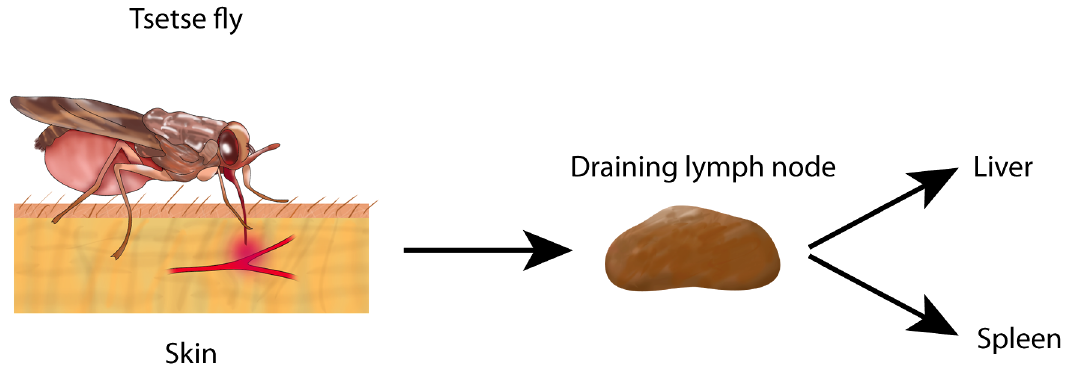
Figure 1. Mode of natural infections by African trypanosomes. Infected tsetse flies bite the host by inserting the proboscis into the skin, inject saliva into the site, and puncture a small blood vessel, resulting in a small hemorrhage. The tsetse fly depicted here is sucking blood from the hemorrhage. During this process, trypanosomes are deposited into the skin. Trypanosomes enter the lymph system and then reach the draining lymph node and the bloodstream. Trypanosomes will circulate in the bloodstream. Whole trypanosomes or fractions thereof end up in macrophages of liver and spleen by antibody- and/or complement-mediated phagocytosis.